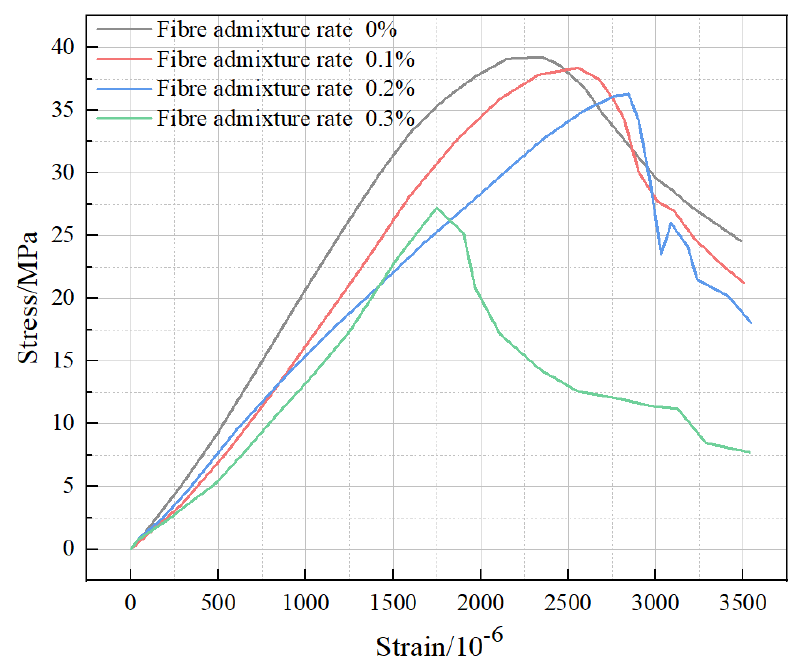
Figure 12. Effect of temperature gradient on BFRC stress–strain curve (freeze–thaw cycles from room temperature to − 196 °C).